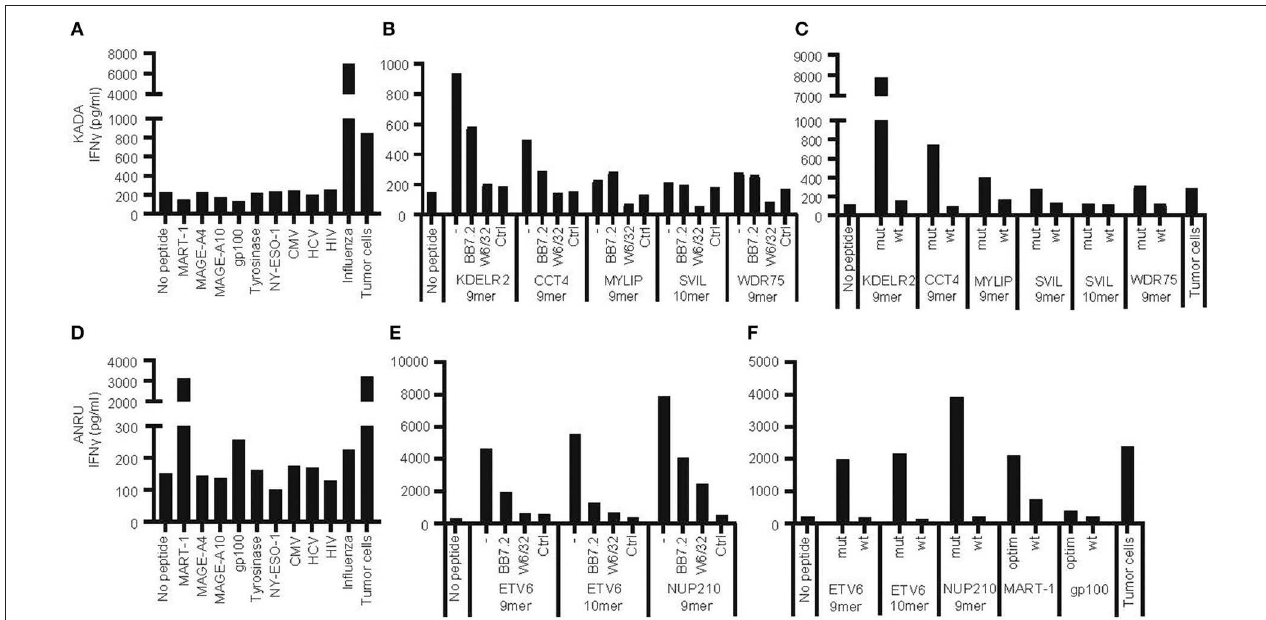
FIGURE 1 | Recognition of autologous tumor cells or peptides from shared tumor-associated antigens, from mutated genes, or from viruses by tumor-infiltrating lymphocytes. Tumor-infiltrating lymphocytes (TIL) and primary tumor cell lines were expanded from tumors of patients KADA and ANRU. The ability of TIL to recognize corresponding tumor cells or HLA-A2-transfected SK-OV-3 target cells pulsed with peptides from common tumor-associated antigens or viruses ( A , KADA; D , ANRU), or HLA-A2-transfected SK-OV-3 cells pulsed with neoepitope peptides derived from mutated genes in tumor cells, in the absence or presence of anti-HLA-A2 (BB7.4) or -MHC-I (W6/32) blocking monoclonal antibodies ( B , KADA; E , ANRU; only recognized peptides shown), or HLA-A2-transfected SK-OV-3 pulsed with neoepitope peptides compared to corresponding wild-type peptides ( C , KADA; F , ANRU), and respond with IFN- γ secretion was assessed after 24h by ELISA. Unpulsed